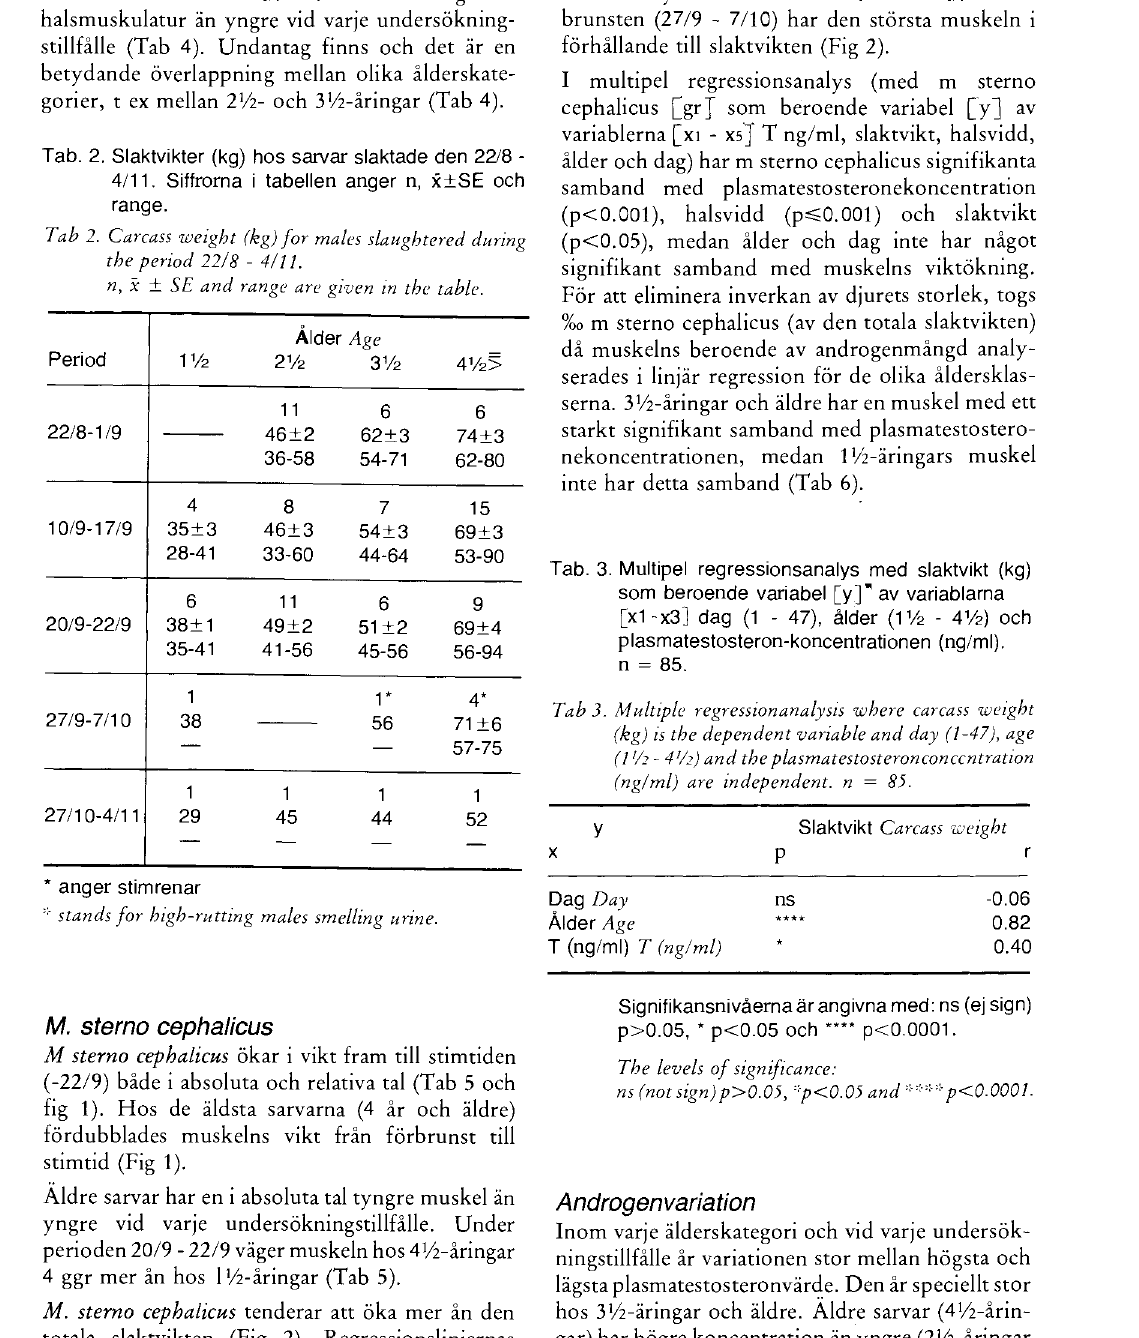
Tab. 3. Multipel regressionsanalys med slaktvikt (kg) som beroende variabel [y]" av variablarna